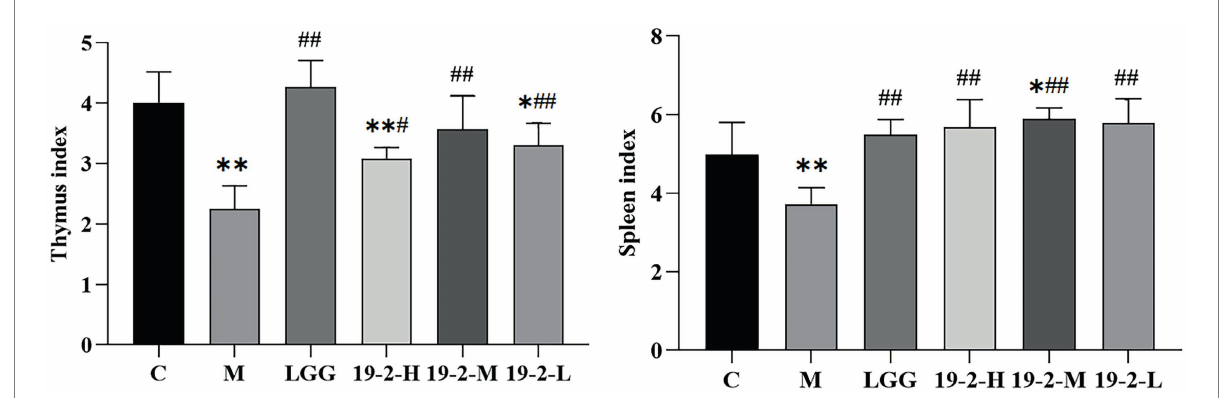
FIGURE 3 Changes in thymus index and spleen index in mice. **, * showed significant difference compared with the control group, p < 0.01, p < 0.05; ##, # represent significant difference compared with group M, p < 0.01, p <